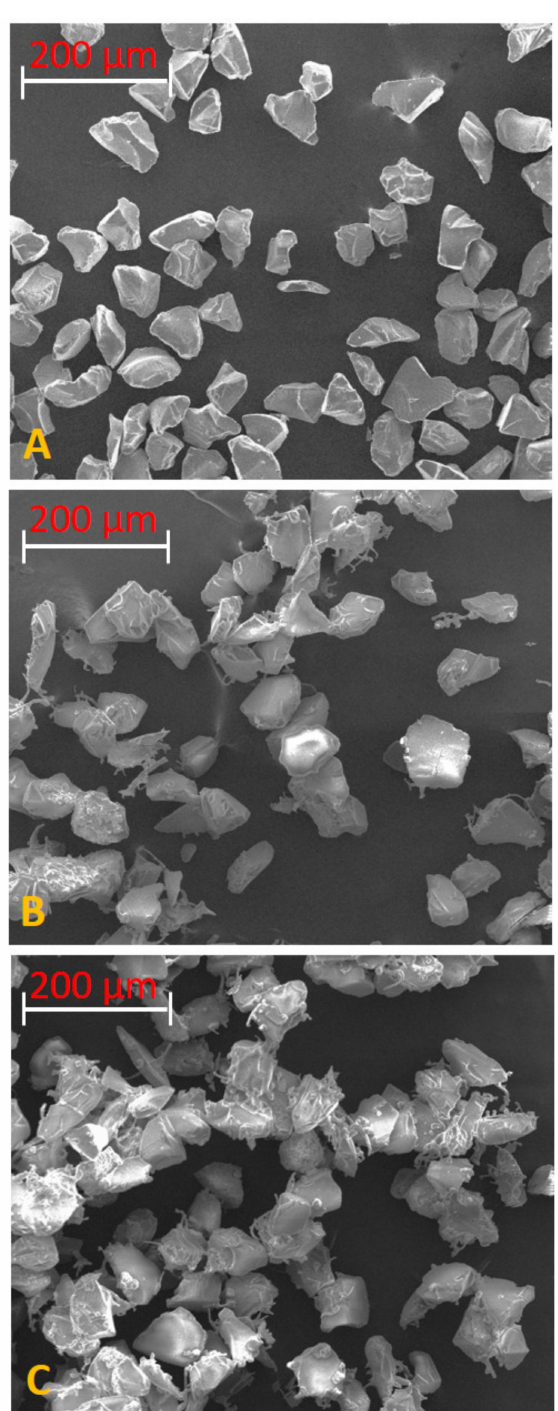
Figure 1. SEM image of silica gel beads impregnated with ( A ) NH 4 HSO 4 , ( B ) HCl.Gly, and ( C ) NH 4